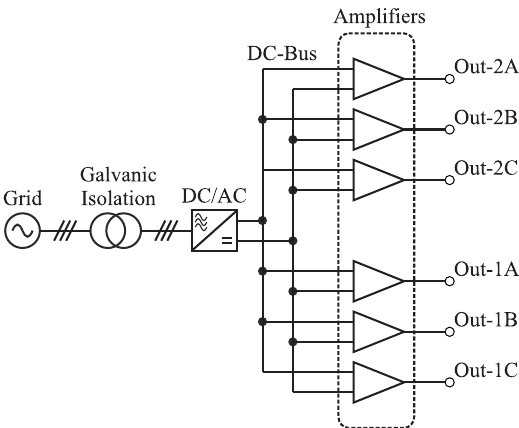
Figure 2. Six output channels of the power amplifier configured as two